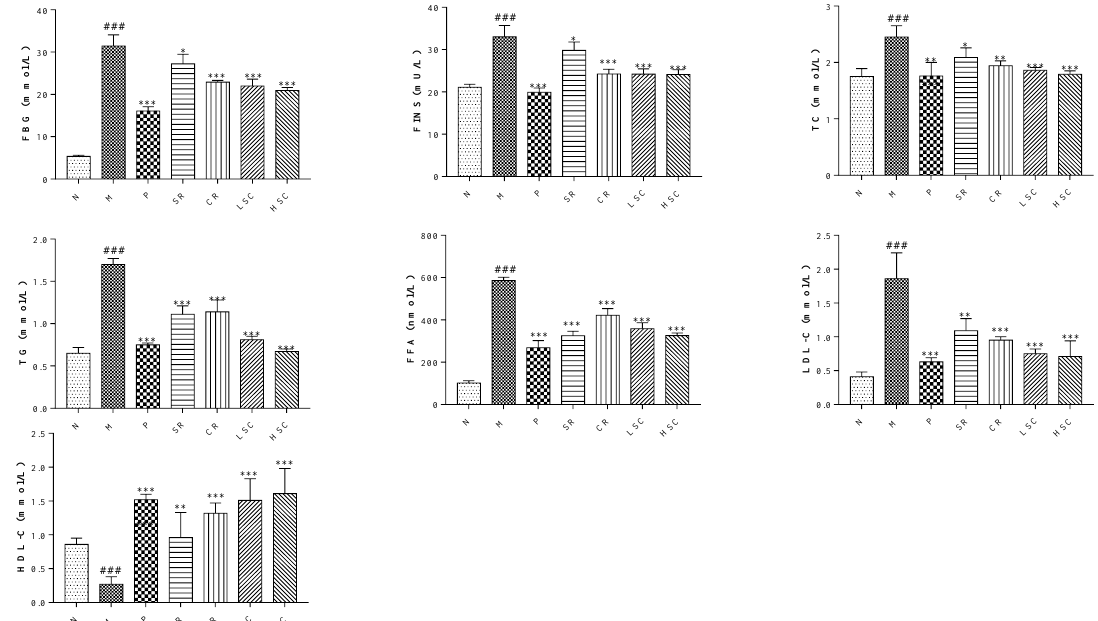
Figure 1. The levels of fasting blood glucose (FBG), fasting insulin (FINS), total cholesterol (TC), triglyceride (TG), free fatty acid (FFA), high-density lipoprotein cholesterol (HDL-C), low-density lipoprotein cholesterol (LDL-C) in serum of the normal group (N), model group (M), and groups gavaged with metformin (P), scutellaria Radix (SR), coptidis Rhizome (CR), low dose of combined extracts group (LSC) and high dose of combined extracts (HSC). The values were shown as mean ± SD. # p < 0.05, ## p < 0.01, ### p < 0.001 vs. normal group; * p < 0.05, ** p < 0.01, *** p < 0.001 vs. model group. Data were analyzed by One-way-ANOVA.